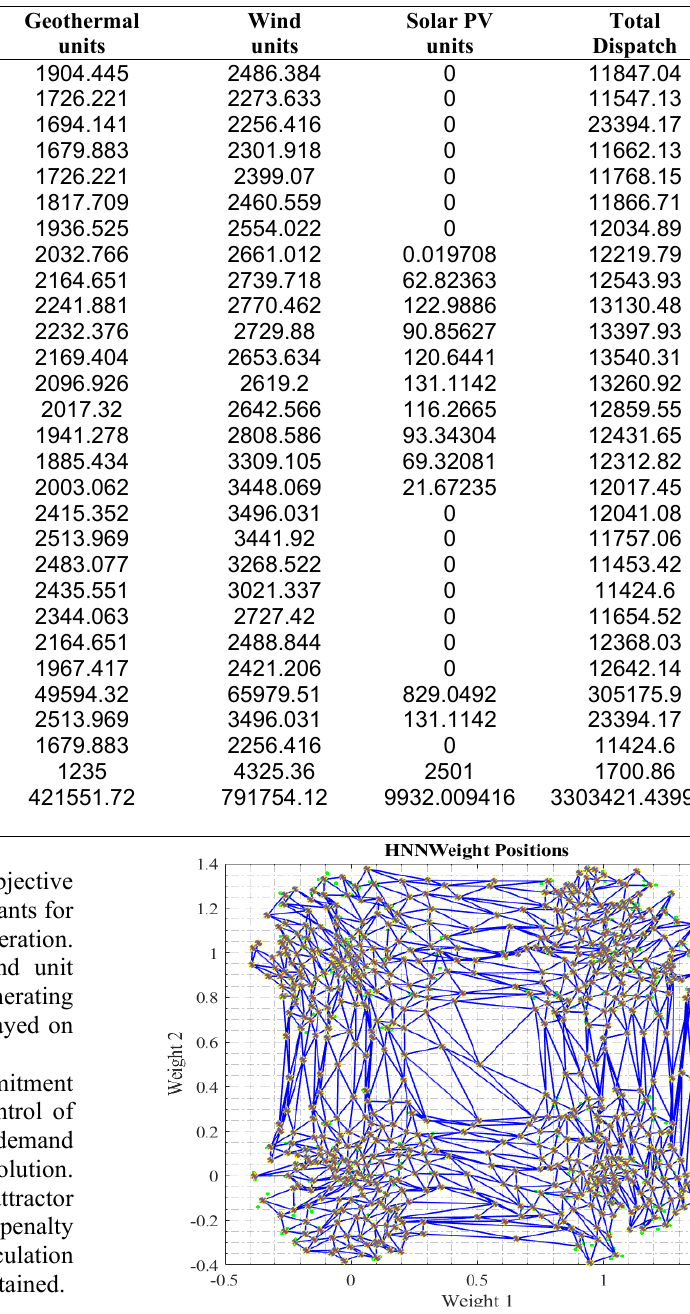
Figure 3. Weight positions of created